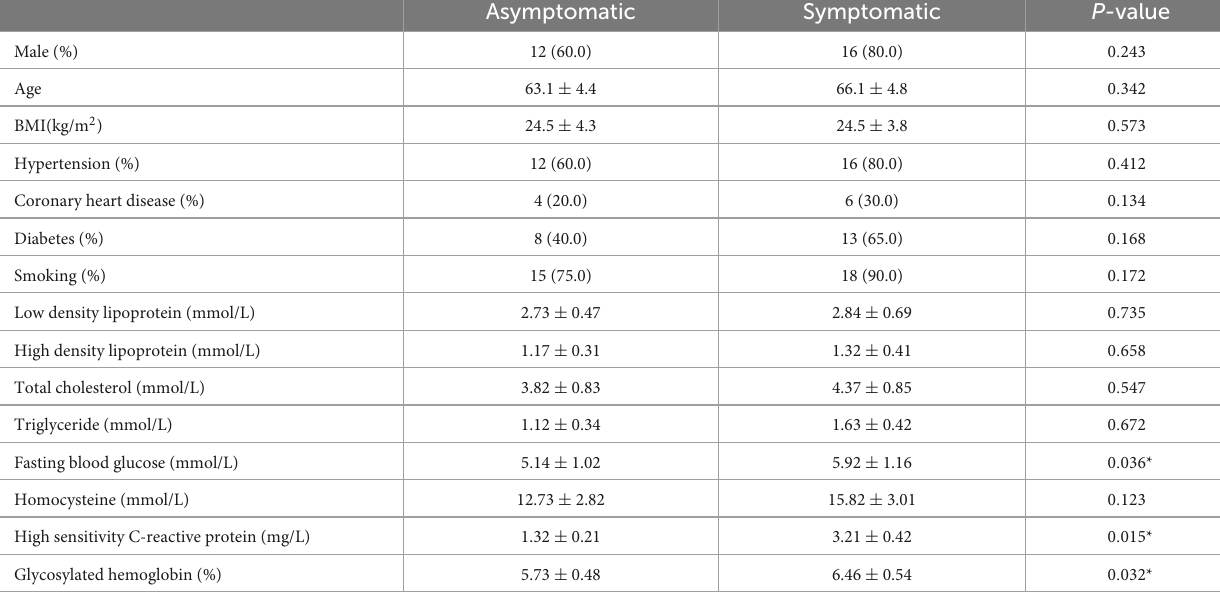
TABLE 2 Patients population.